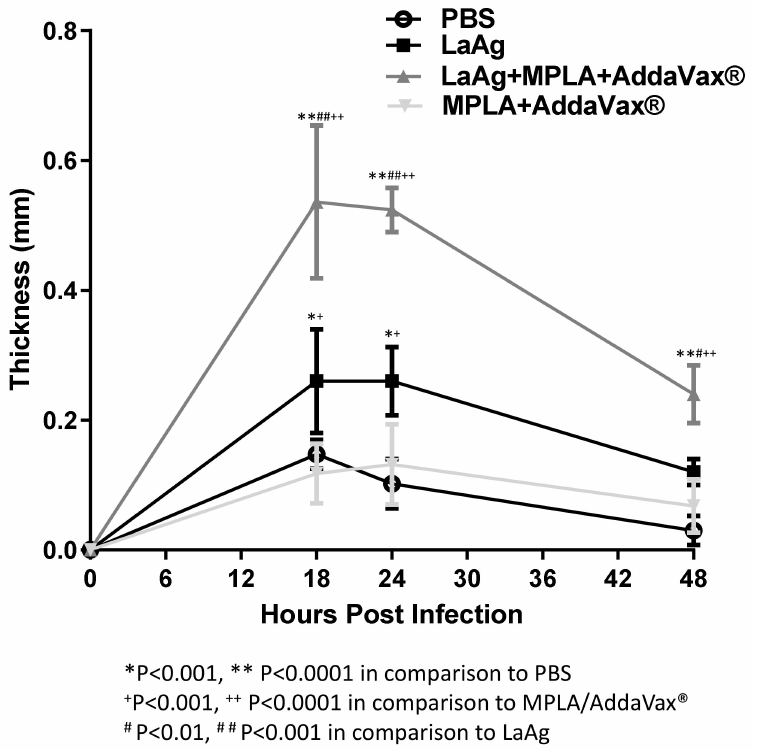
Figure 2. Intramuscular LaAg vaccine associated with the adjuvants monophosphoryl lipid A (MPLA)/AddaVax ® induces a strong delayed hypersensitivity response. Mice were immunized with LaAg and MPLA/AddaVax ® alone or together, while controls received PBS alone. Animals were then challenged with 2 × 10 5 L. amazonensis stationary phase promastigotes in the right hind footpad and the kinetics of the hypersensitivity response were scored at 18, 24, and 48 h post-infection. Data are representative of two independent experiments (mean ± standard deviation; n = 5) ** p < 0.0001, * p < 001 in comparison with PBS; + p < 0.001, ++ p < 0.0001 in comparison with MPLA/AddaVax ® ; # p < 0.01, ## p < 0.001 in comparison with LaAg; assessed by two-way ANOVA using Bonfer- roni’s